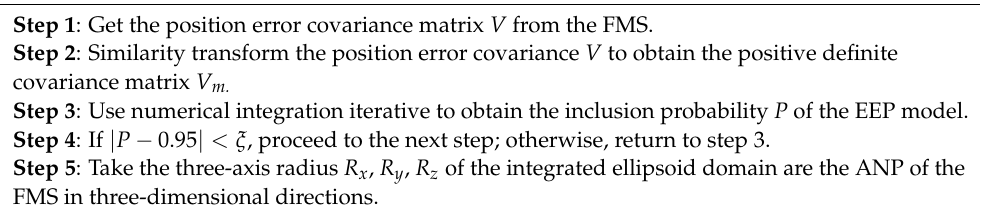
Algorithm 1: Calculation process of three-dimensional ANP evaluation method